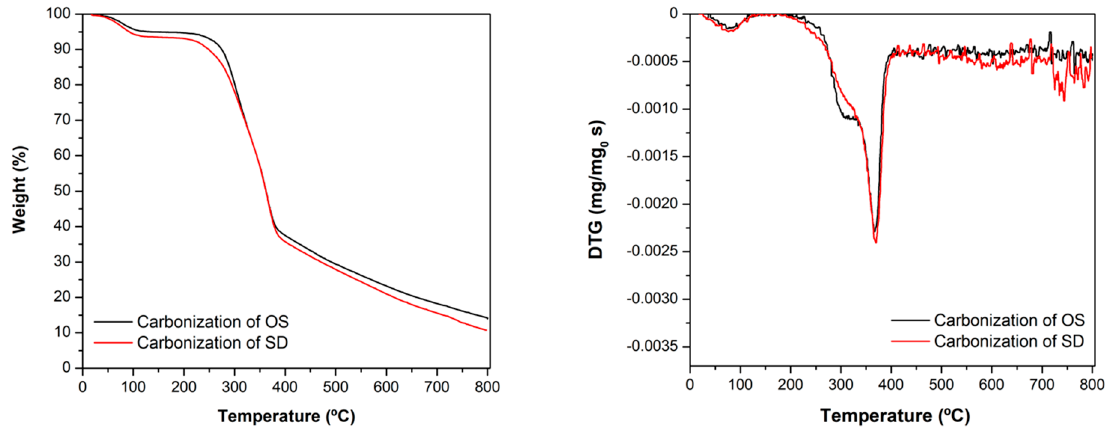
Figure 1. TG-DTG profiles for the carbonization of OS and SD residues.